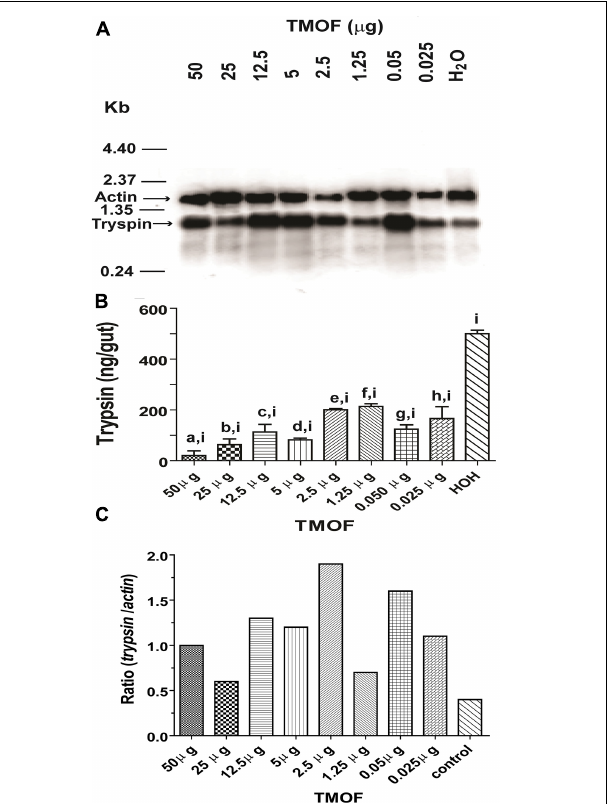
FIGURE 8 | Comparison between C. quinquefasciatus late trypsin transcript and trypsin amount in the gut after injection of TMOF to blood-fed females and analyzing the guts at 30 h. (A) Northern blot analysis of the late trypsin transcript in gut epithelial cells after injecting different amounts of TMOF (0.025 to 50 µ g). Water injection was used as a control and actin to show transfer in all the lanes. The Northern blot was repeated twice showing similar results. (B) Trypsin amounts (ng/gut) of gut epithelial cells that were injected with different amounts of TMOF or water control as in (A) . Results are expressed as means of 3 determinations + SEM. Significant differences between different amounts of injected TMOF and water control ( p < 0.05) were denoted by a combination of two small letters (a,i; b,i; c,i; d,i; e,i; f,i; g,i; h,i). Significant differences in trypsin biosynthesis after injecting different amounts of TMOF into female C. quinquefasciatus (a, b, c, d, e, f, g, h, and i) were determined using one-way ANOVA ( p < 0.0001, n = 9, F38.98, R = 0.9454). (C) The ratios of the trypsin/actin transcripts in (A) after injecting different amounts of TMOF into C. quinquefasciatus were plotted and compared with injections of water